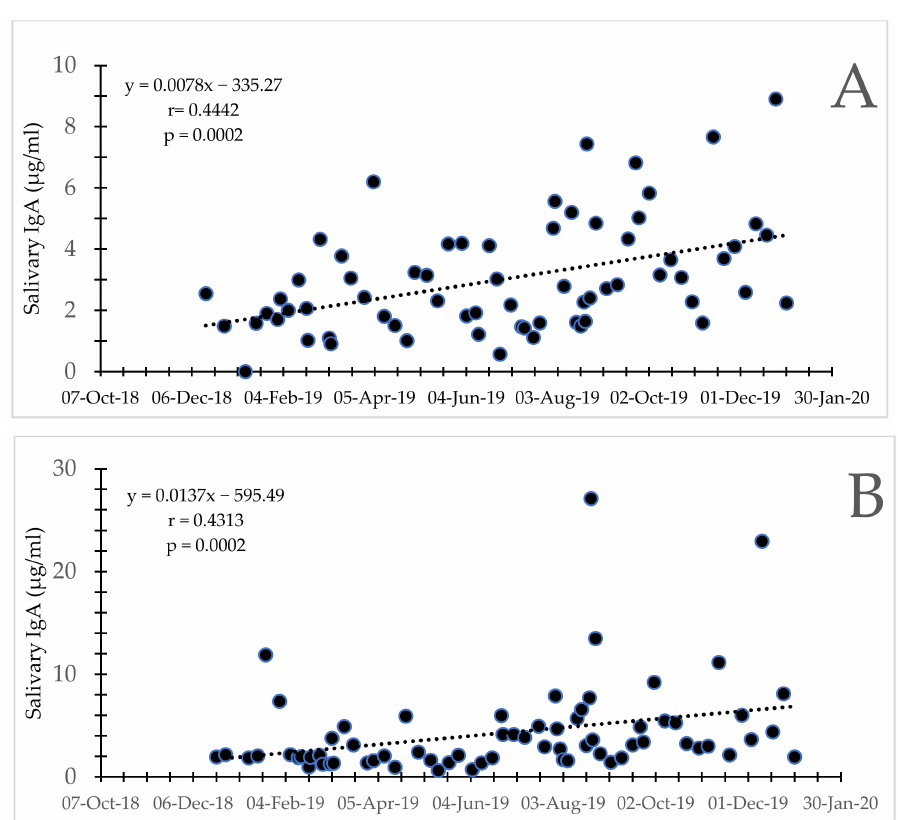
Figure 3. Bull Asian elephants during social integration. Secretory IgA concentrations for Bull 4